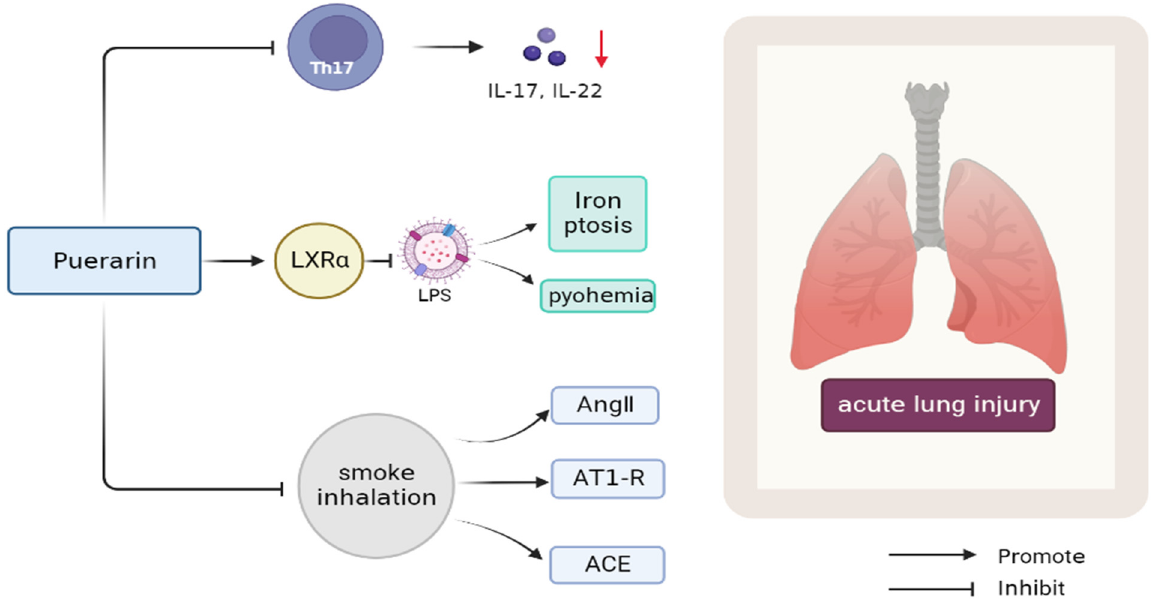
Figure 2. Mechanism of puerarin in improving ALI inflammation caused by gunpowder smog [45].